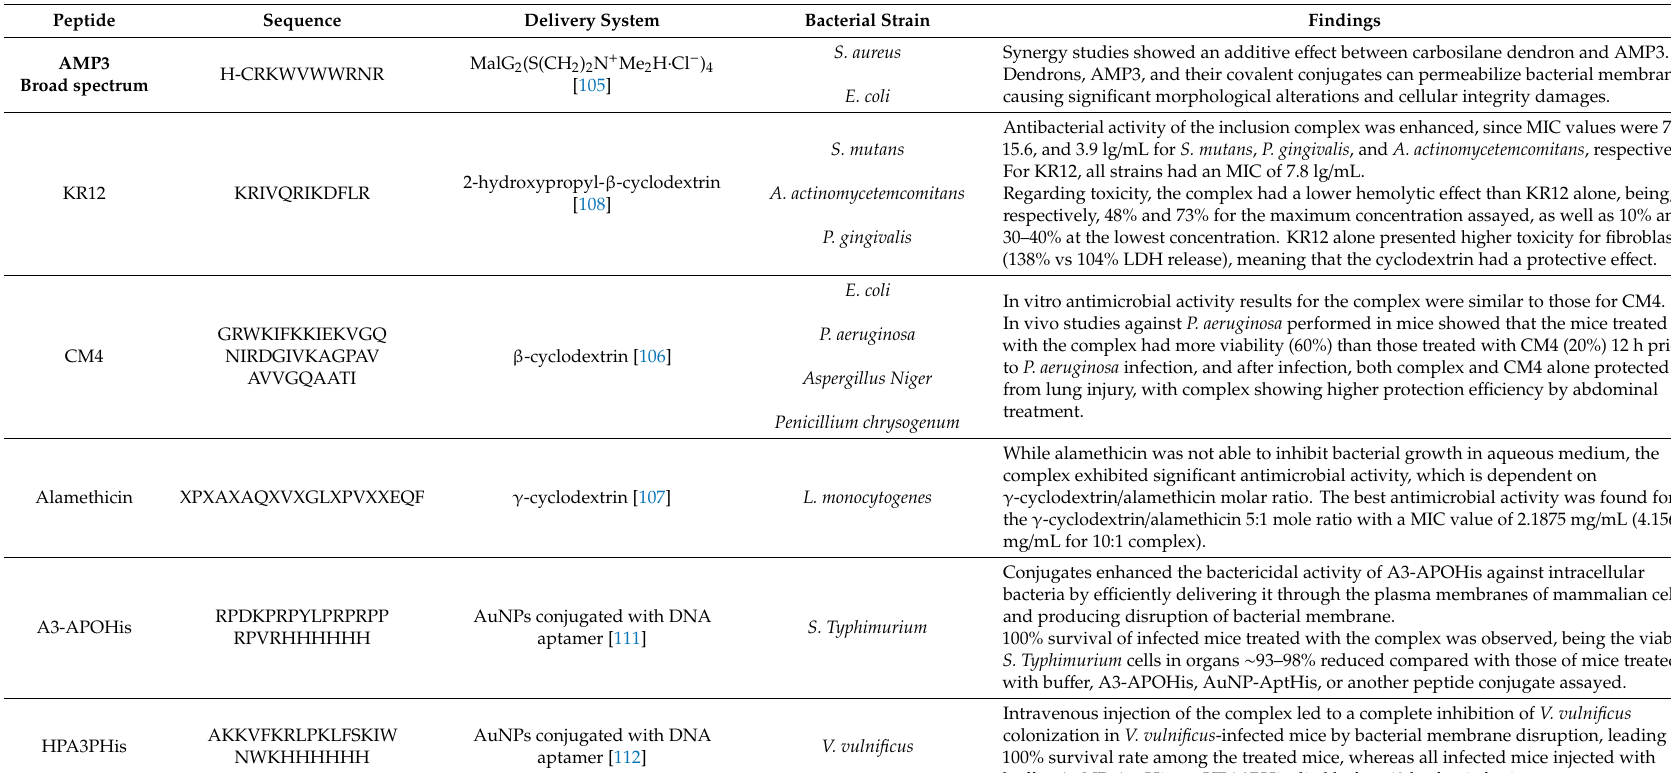
Table 5. Overview of dendrimers, cyclodextrins, and aptamers as delivery systems for